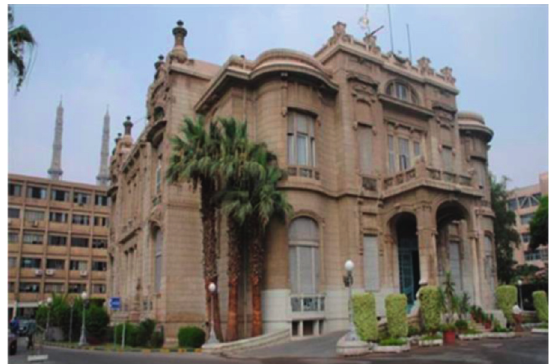
Figure 3: Saffron Palace.